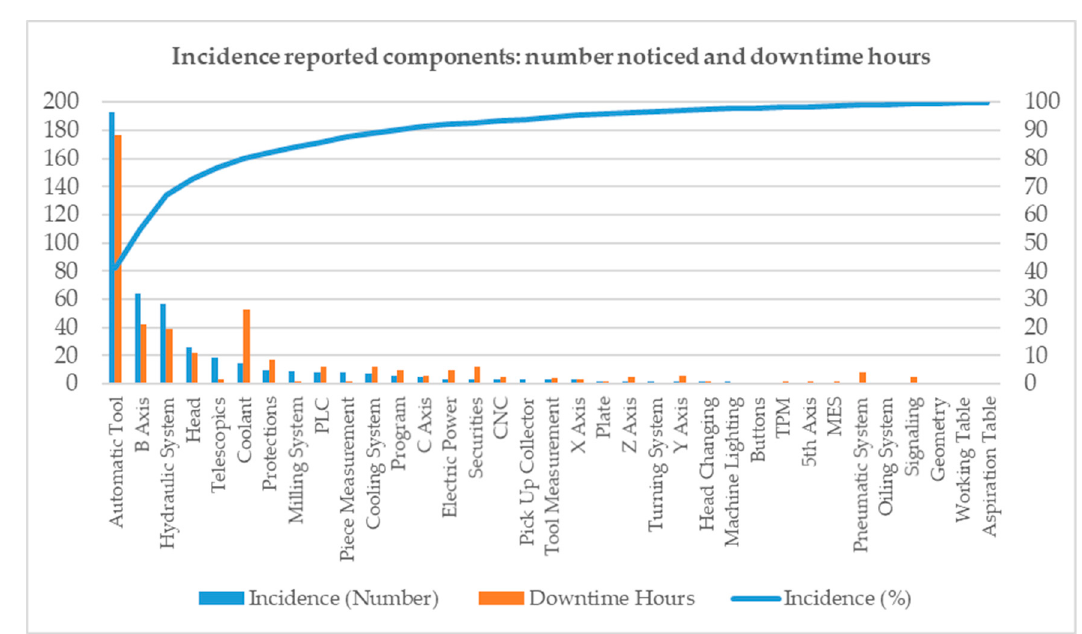
Figure 6. Accumulated number of notices and hours of machinery stoppages.